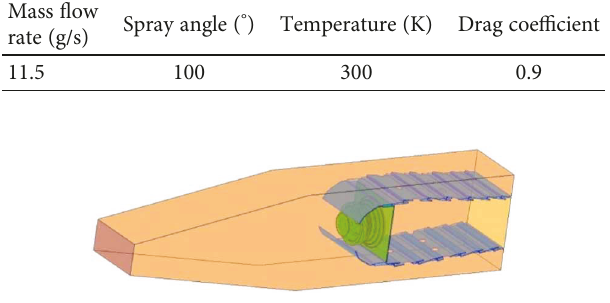
Figure 8: Geometry of the combustion chamber.